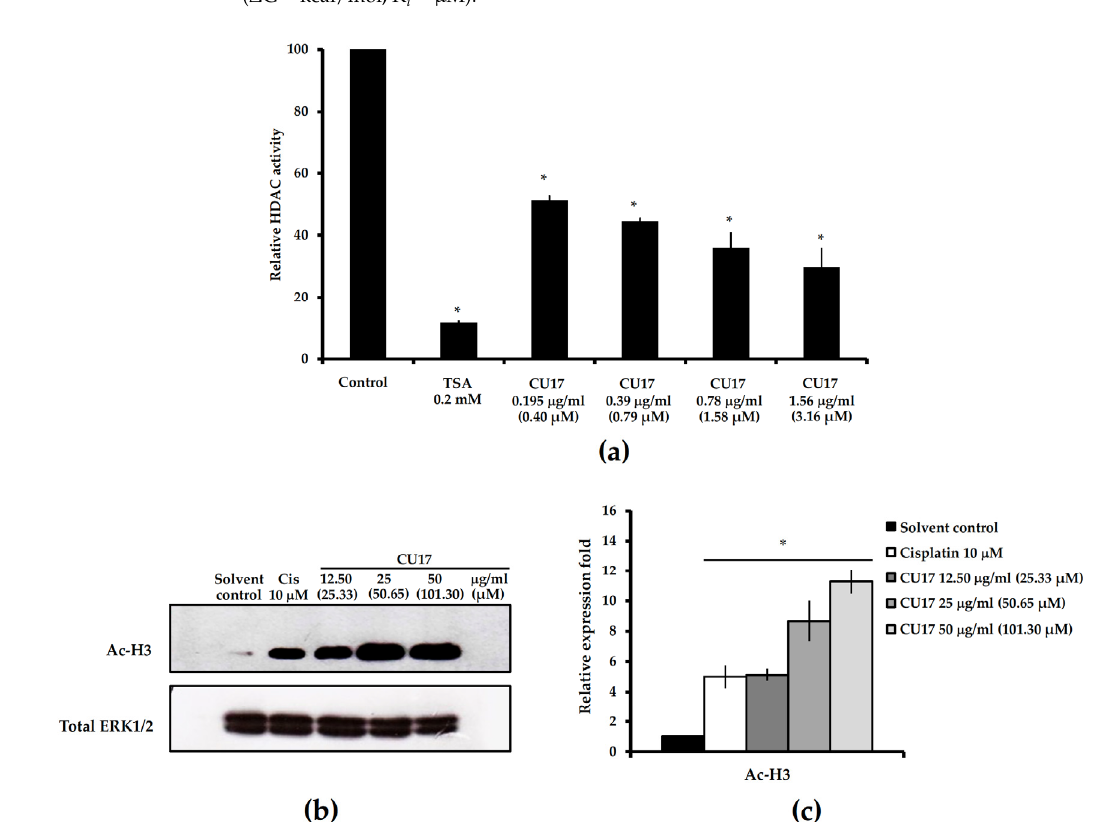
Figure 2. HDAC inhibitory activity of CU17. ( a ) In vitro HDAC inhibitory activity of CU17 was analyzed by the Fluor-de-Lys HDAC Fluorometric Activity Assay Kit. Bar graphs were expressed as relative HDAC activity with respect to the control (DMSO). Trichostatin A (TSA) was used as a positive control. Each value represents the mean ± SD from three independent experiments. ( b ) Western blot analysis of hyperacetylation of histone H3 in A549 cells after exposure to varying concentrations of CU17 for 24 h. DMSO: ethanol (1:1, v / v ) and cisplatin (10 µM) were used as negative and positive controls, respectively. Total ERK1/2 was used as a loading control for Western blotting. ( c ) The relative fold of protein expression was calculated using the intensity of the protein band in comparison to a loading control and shown as a bar graph. Bar graph displayed the mean from three independent experiments. * p < 0.05 indicates a significant difference between the treatment and solvent control.